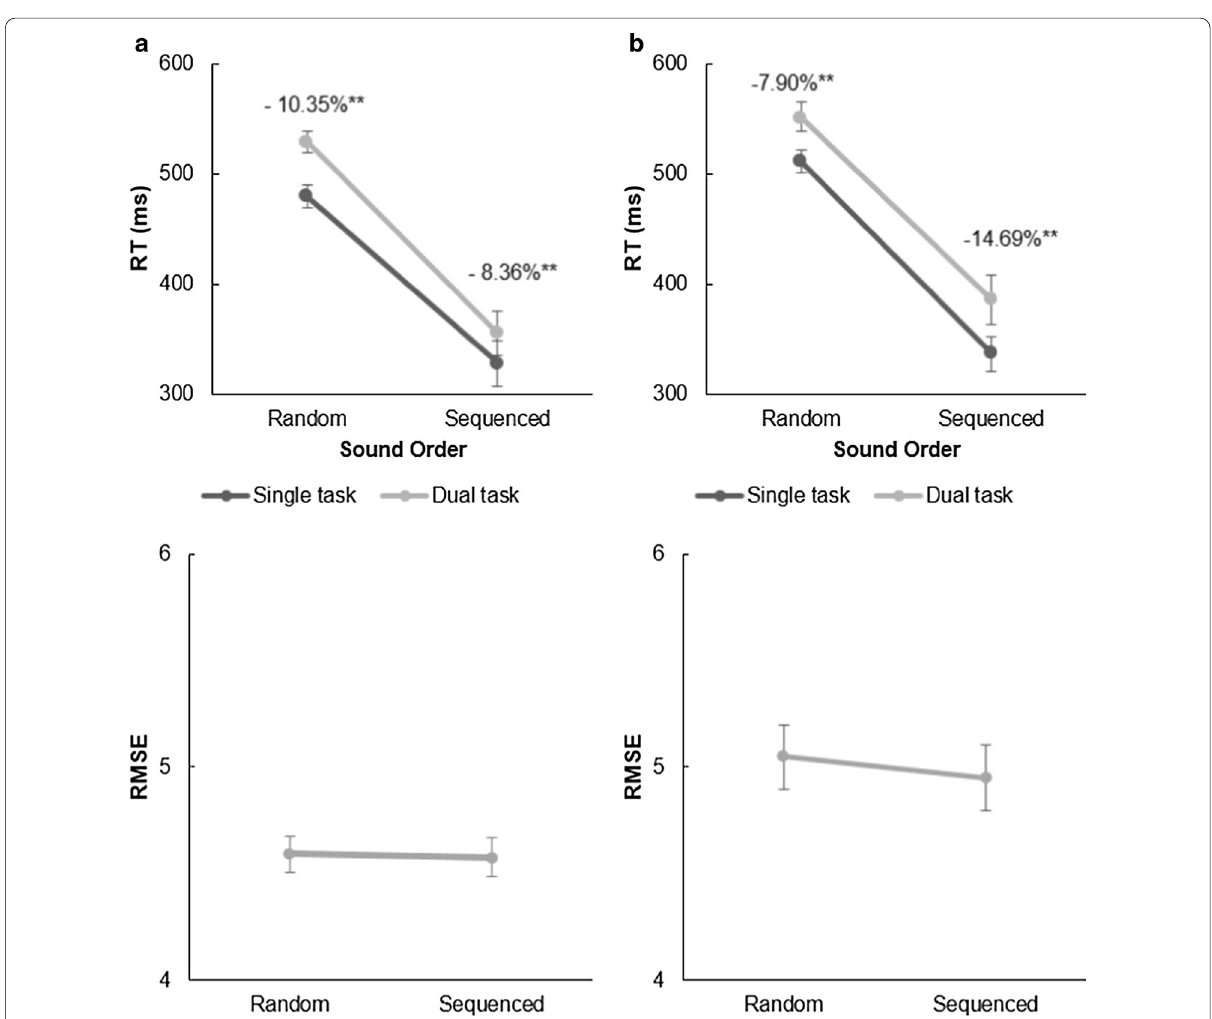
Fig. 8 Reaction time (RT) and root-mean-square error (RMSE) analyses in Experiment 2a ( a ) and 2b ( b ). Light gray lines depict dual-task conditions, dark gray lines depict single-task conditions. DT costs are the differences between single- and dual-task conditions, presented as percentages; asterisks denote significant DT costs, ** p < .001, * p < .005. Error bars show standard errors